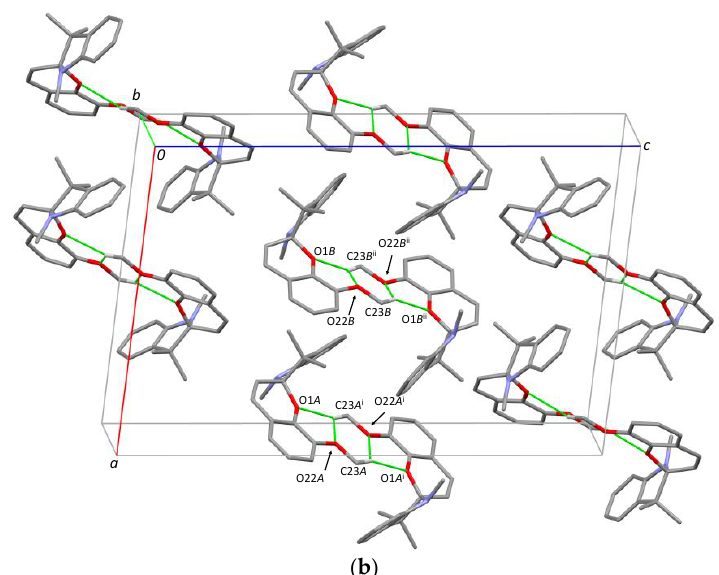
Figure 4. ( a ) A perspective view of (IVa), showing the atom-numbering scheme. Displacement ellipsoids are drawn at the 50% probability level. ( b ) A partial packing diagram for (IVa). Unique Van-der-Waals interactions are indicated as green dashed lines. [Symmetry code: (i) 2 − x, 1 − y, 1 − z; (ii) 1 − x, 1 − y, 1 − z].